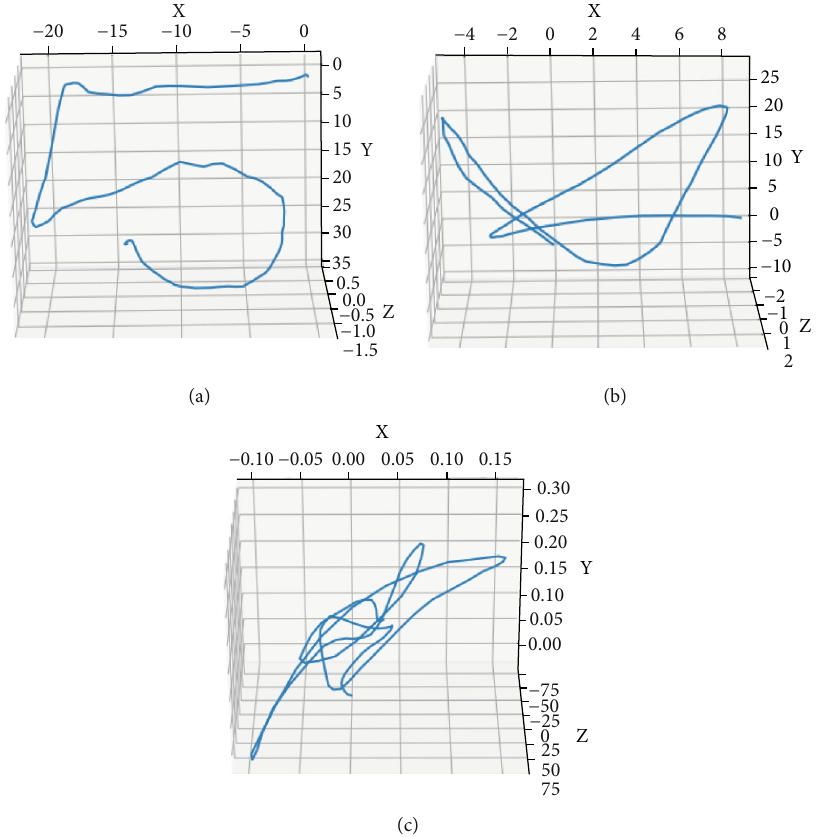
Figure 2: Normalized dataset samples. (a) The RTD dataset for sample digit “ 5. ” (b) The RTC dataset for sample character “ A. ” (c) The smart-band dataset for sample character “ A. ” Normalization is not required in case of Abas dataset.